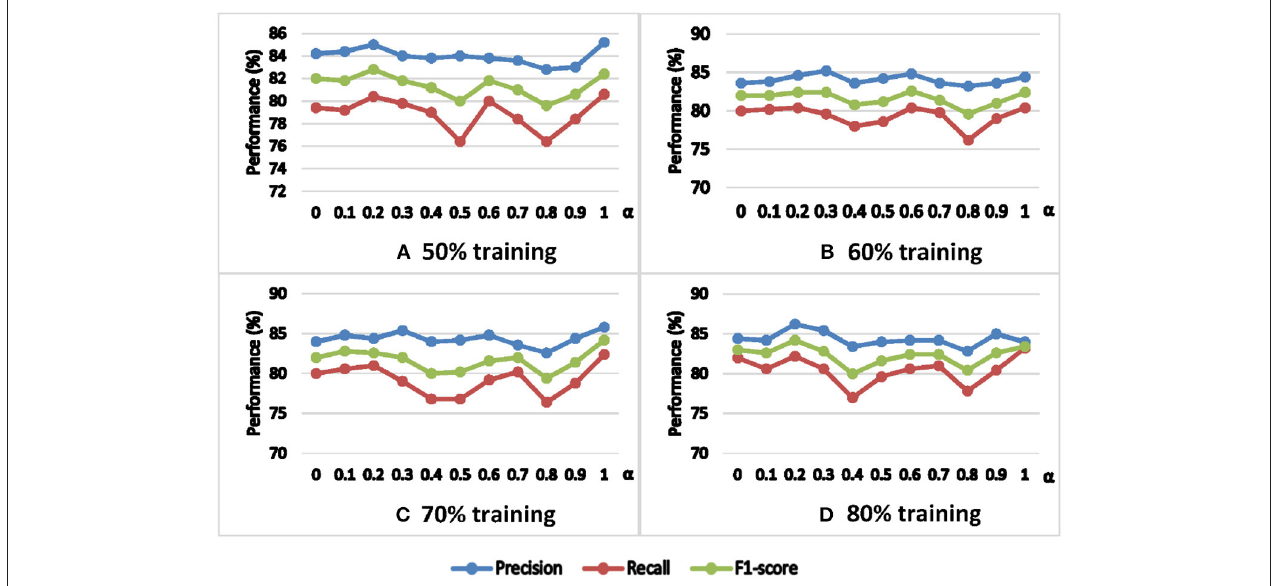
FIGURE 5 | Classification performance on the parameter α with different training